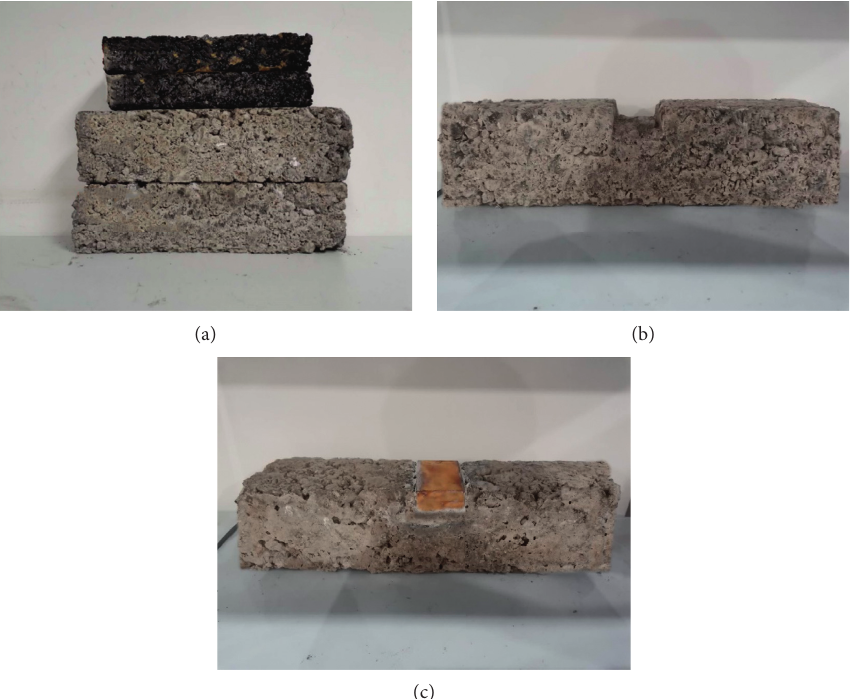
Figure 11: Different working conditions for structural layer model specimens. (a) Complete model test piece of pavement structure. (b) Model test piece of structural layer void. (c) Structural layer repair model test piece.